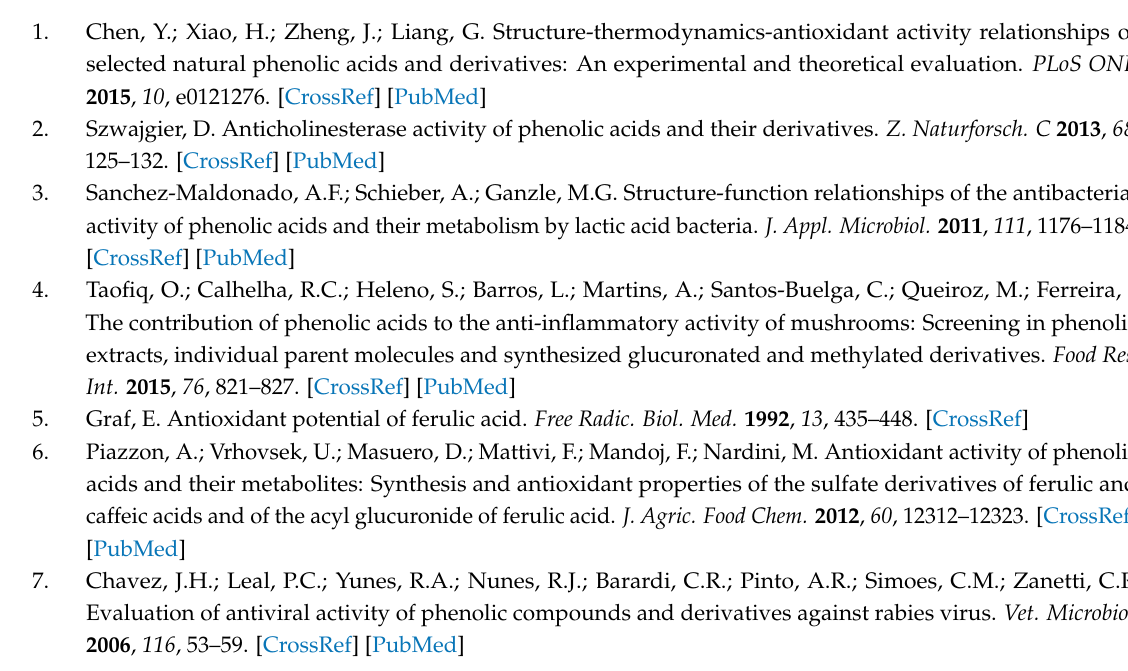
Figure S1: MS spectra of N - trans -caffeoyldopamine, Figure S2: MS spectra of N - trans -feruloyldopamine, Figure S3: 1 H-NMR spectra of N - trans -caffeoyldopamine, Figure S4: 1 H-NMR spectra of N - trans -feruloyldopamine, Figure S5: 13 C-NMR spectra of N - trans -caffeoyldopamine, Figure S6: 13 C-NMR spectra of N - trans